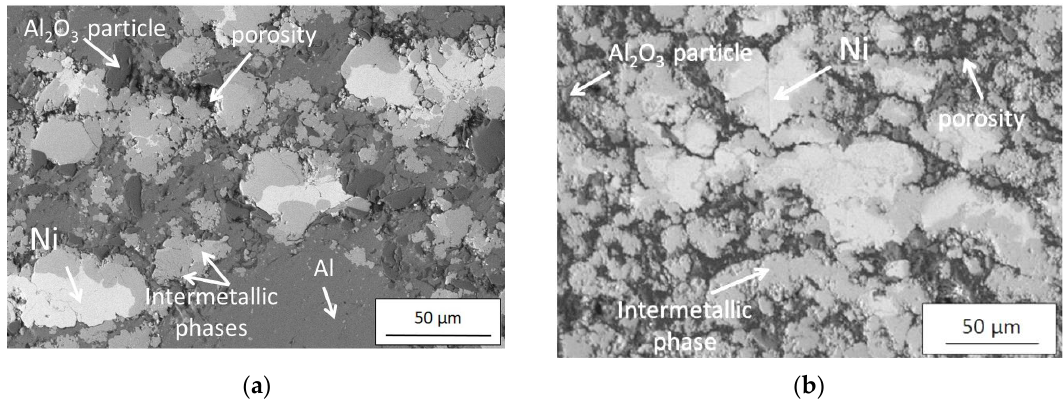
Figure 4. Micrographs (SEM, BSE) of 16% Al coating heated in furnace at 560 °C ( a ) and 620 °C ( b ). Coatings 2020 , 10 , 581